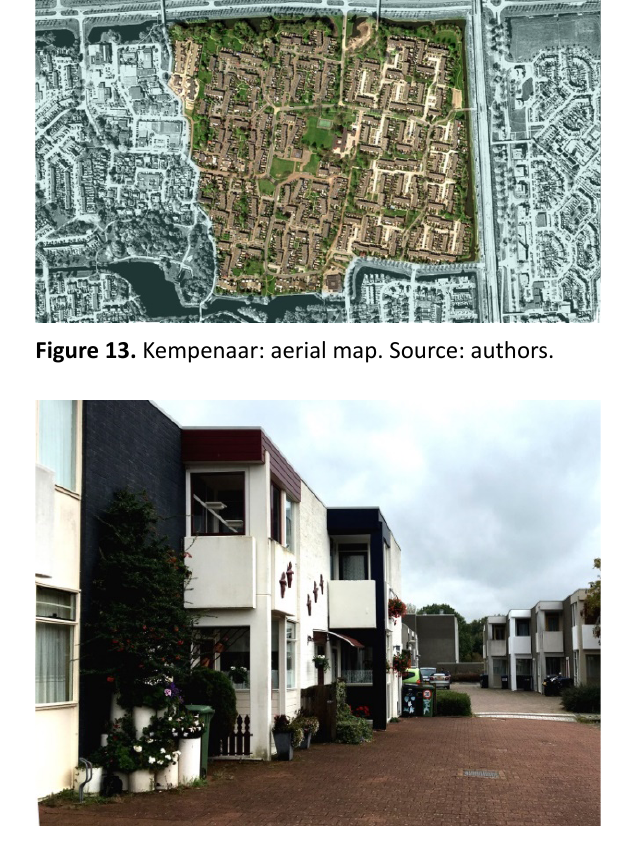
Figure 14. Kempenaar: view of staggering